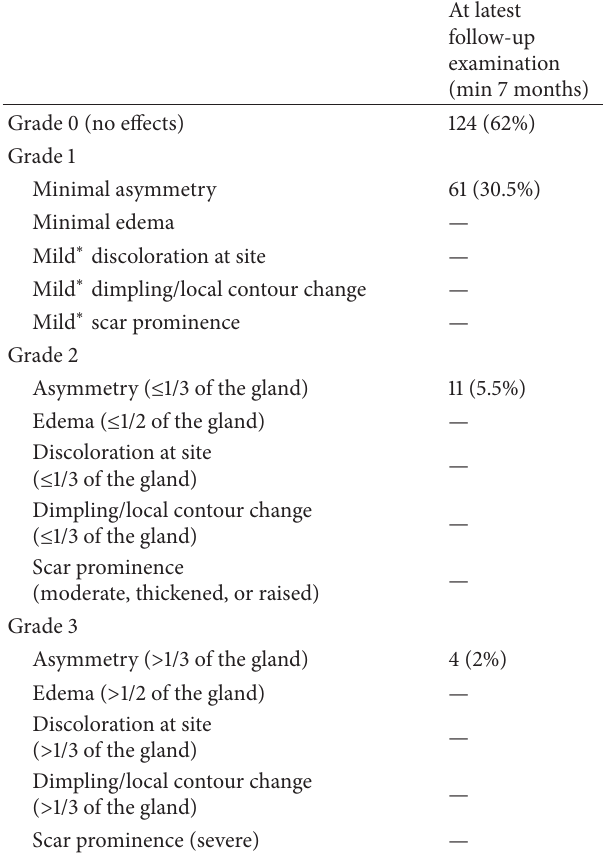
Table 5: Cosmetic